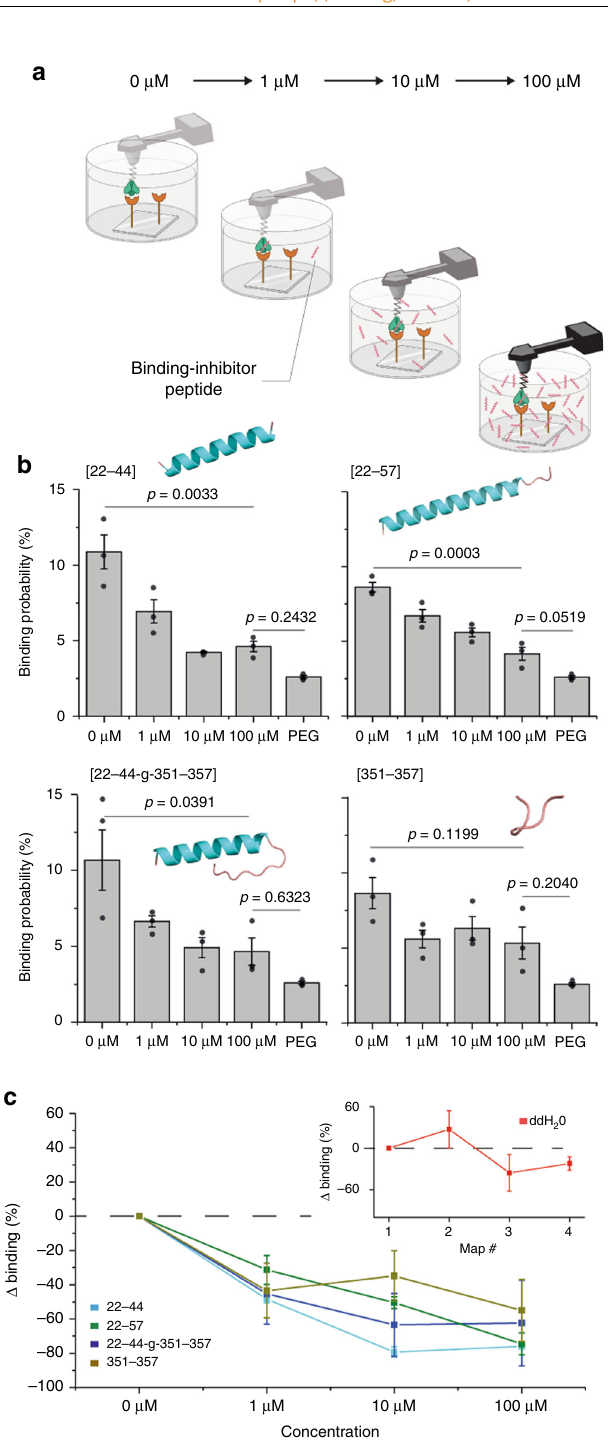
pcDNA3.1( + ) ACE2 – eGFP was transfected to A549 cells (60-mm plate) using 6 μ l of Lipofectamine LTX and 2 μ l of PLUS reagent (Invitrogen). Functionalization of AFM tips . PFQNM-LC and MSCT-D cantilevers (Bruker) were used to probe the interaction between S1 subunit (Genscript, #U5377FC120) or RBD protein (Genscript, #U5377FC120) and ACE2 protein (Sino Biological, 90211-C02H). NHS-PEG 24 -Ph-aldehyde linkers were used to functionalize AFM tips as previously described 30 . Brie fl y, the cantilevers were immersed in chloroform for 10 min and further cleaned in a UV radiation and ozone (UV-O) cleaner (Jetlight), and immersed overnight in an ethanolamine solution (3.3 g of ethano- lamine in 6.6 ml of DMSO). They were washed with DMSO and ethanol three times, respectively. Ethanolamine-coated cantilevers were immersed in NHS- PEG 24 -Ph-aldehyde solution (3.3 mg of it was diluted in 0.5 ml of chloroform and